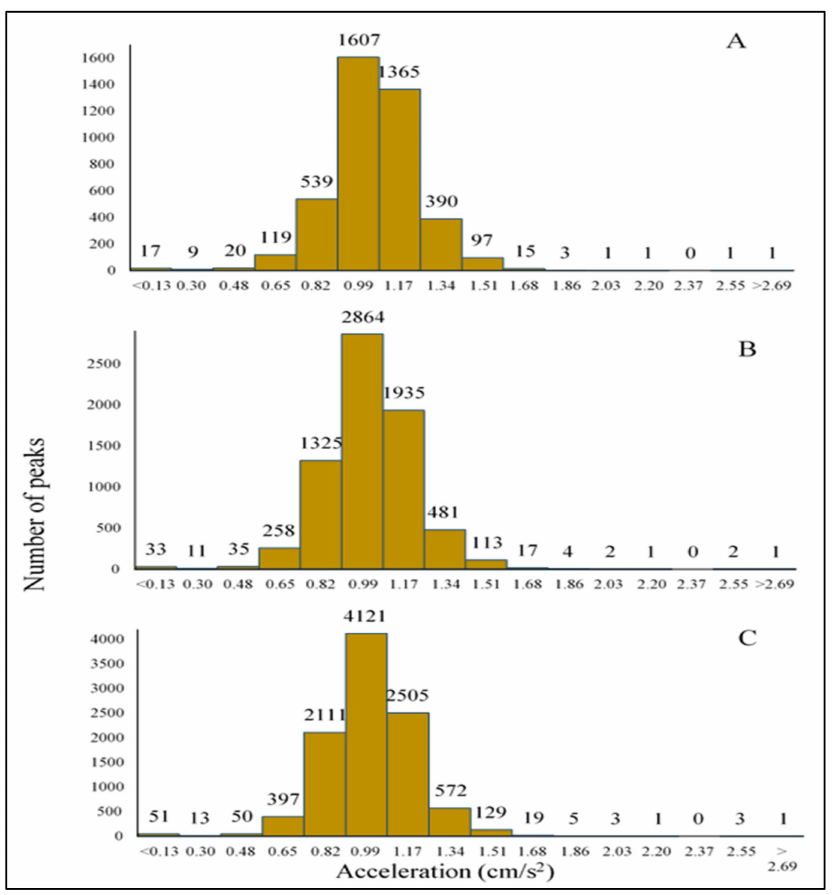
Figure 2. The number of peaks (signals) generated during transport for each acceleration interval (cm/s 2 ) from ( A ) 100 km ( B ) 154 km and ( C ) 205 km distances using a